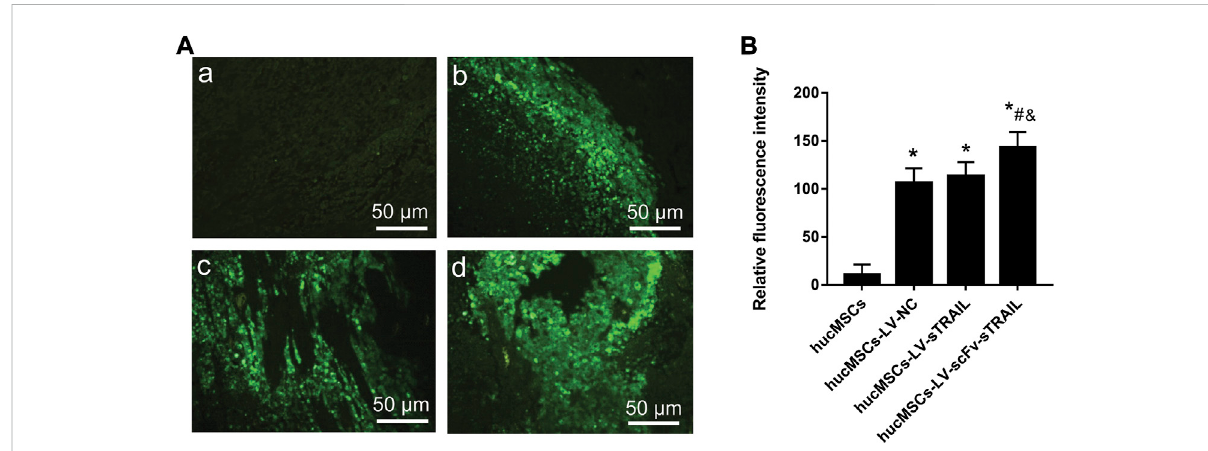
FIGURE 7 Fluorescencemicroscopicobservationofparaf fi nembeddedsectionsoftumortissues. (A) Representative images of fl uorescence microscope observations (magni fi cation ×200). a: hucMSCs group; b: hucMSCs-LV-NC group; c: hucMSCs-LV-sTRAIL group; d: hucMSCs-LV-scFv-sTRAIL group. (B) The quantitative data of fl uorescence intensity. Scale bar = 50 μ m n = 5, * p < 0.05 versus the hucMSCs group; # p < 0.05 versus